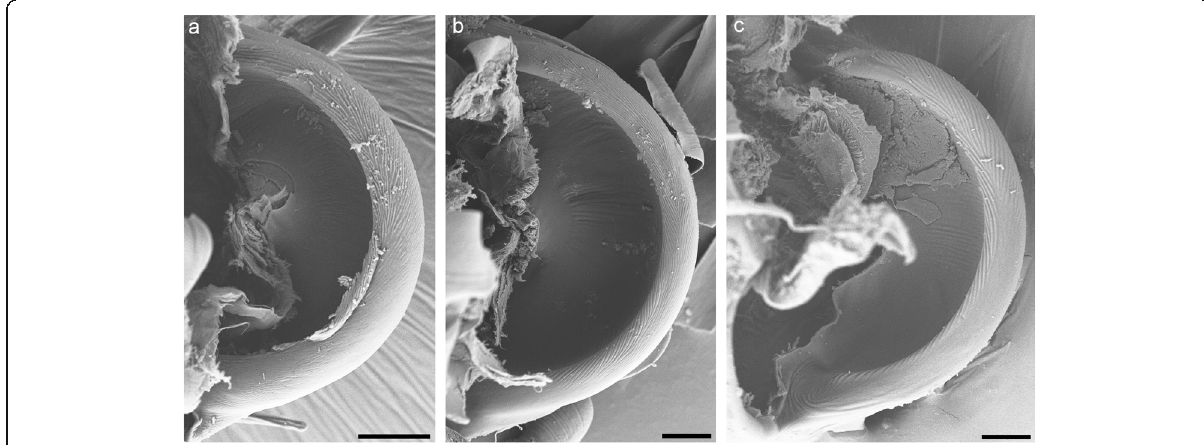
Fig. 9 Propodal processes in other oniscideans. Scanning electron micrographs of the propodal processes in Ligidium hypnorum ( a ), Titanethes albus ( b ) and Cylisticus convexus ( c ). The processes are similar in shape and surface patterning, with slightly finer ridges in T. albus . Scale bars: 10 μ